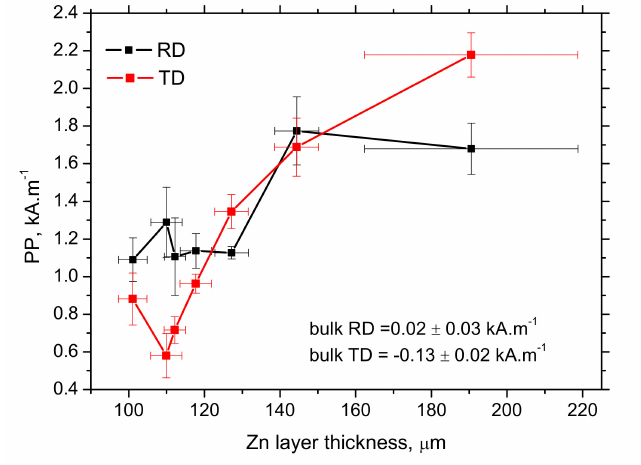
Figure 11. Evolution of PP along with increasing Zn coating (layer) thickness (obtained from the MO).